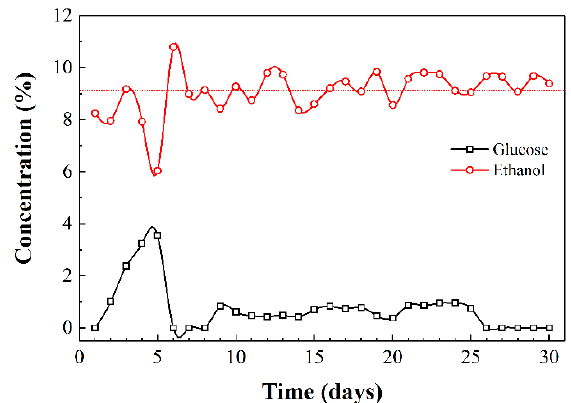
Figure 1. Semi-continuous fermentation and simultaneous saccharification (SFSS) kinetics of the cellulosic fraction of SCB using Saccharomyces cerevisiae : Ethanol concentration (% v / v ) and glucose concentration (%).